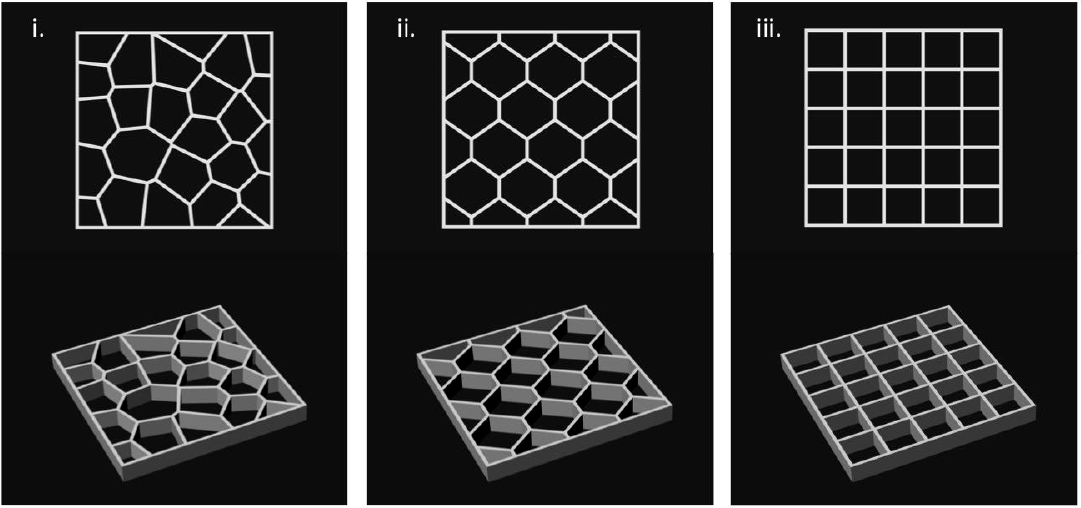
Figure 1. Scaffold designs: ( a ) voronoi, ( b ) hexagon, ( c ) grid.